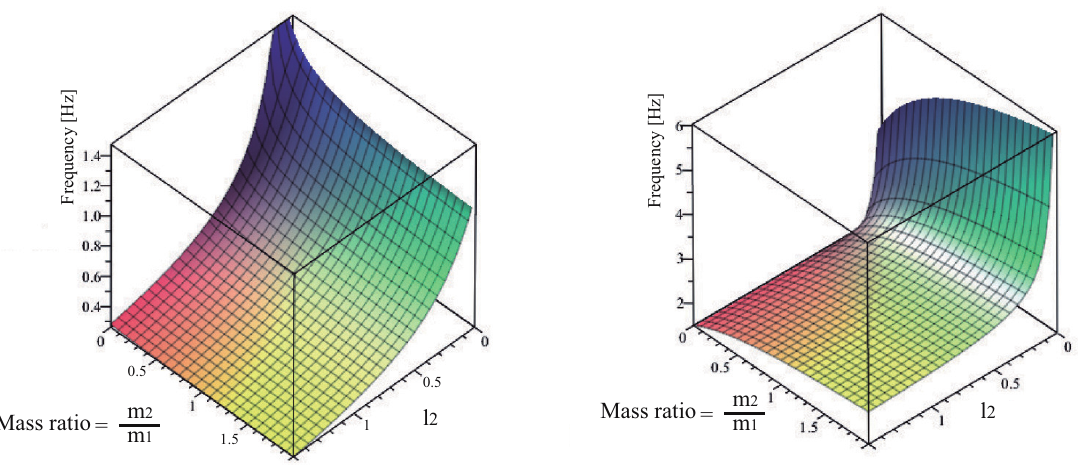
Figure 11. Variation of first and second mode frequencies when 0 < l 2 < 1.5 and 0 < R < 2.